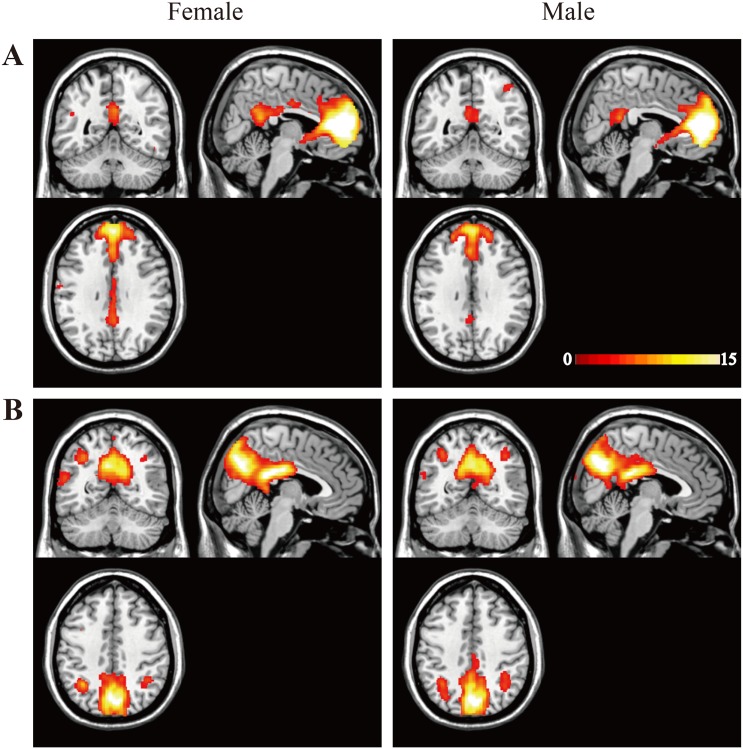
Independent component analysis (ICA) results.The average components for females and males are shown in the left and right columns, respectively. (A) Independent components of the anterior default mode network (DMN). (B) Independent components of posterior DMN. The maps depict the statistical threshold for both results set at p = 0.05 with whole-brain FWE correction. The coordinates for the panels above are (A) (4, -52, 32) and (B) (4, -58, 42). Color bars denote the t-statistic range.